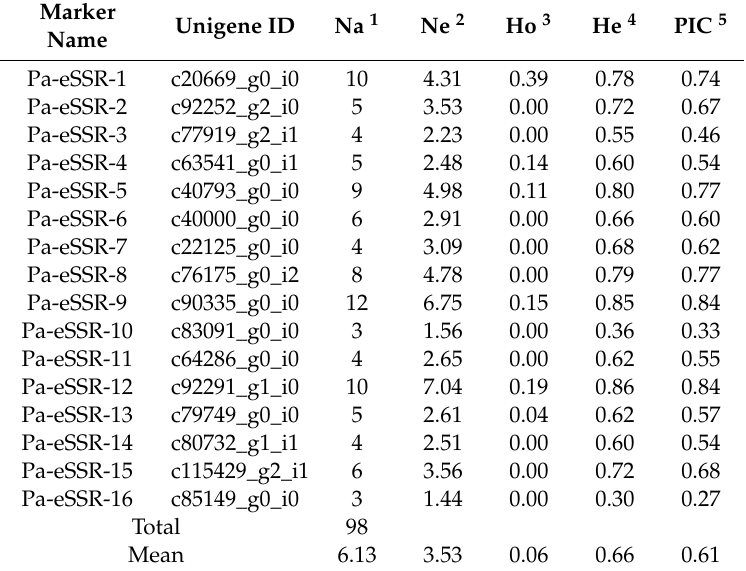
Diversity parameters associated with 16 polymorphic EST-SSRs analyzed in 28 avocado